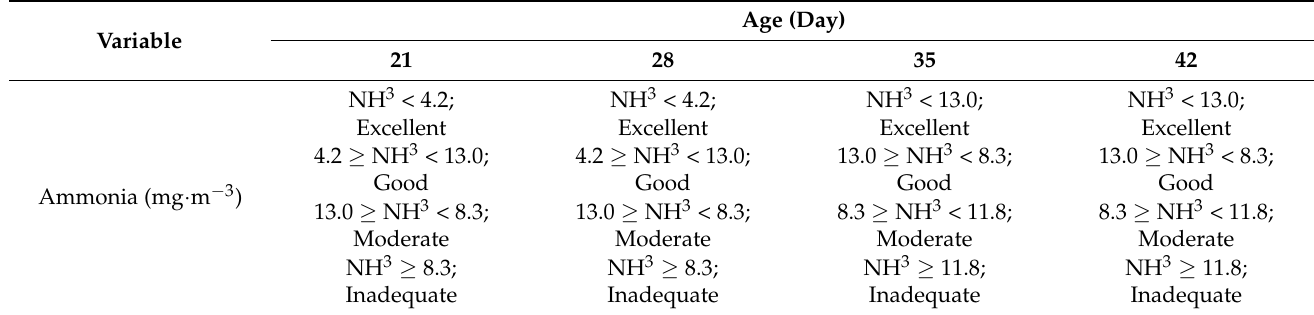
Table 3. Range of ammonia concentration (mg · m − 3 ) and its impact in the rearing environment corresponding to the broiler